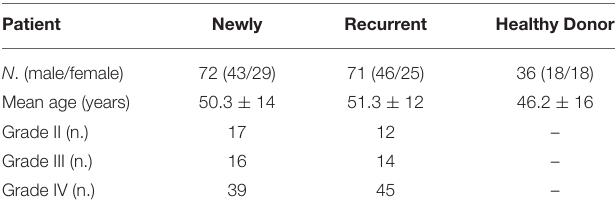
TABLE 1 | Study population of healthy donors ( n = 36) and patients with glioma ( n = 143). Patient Newly